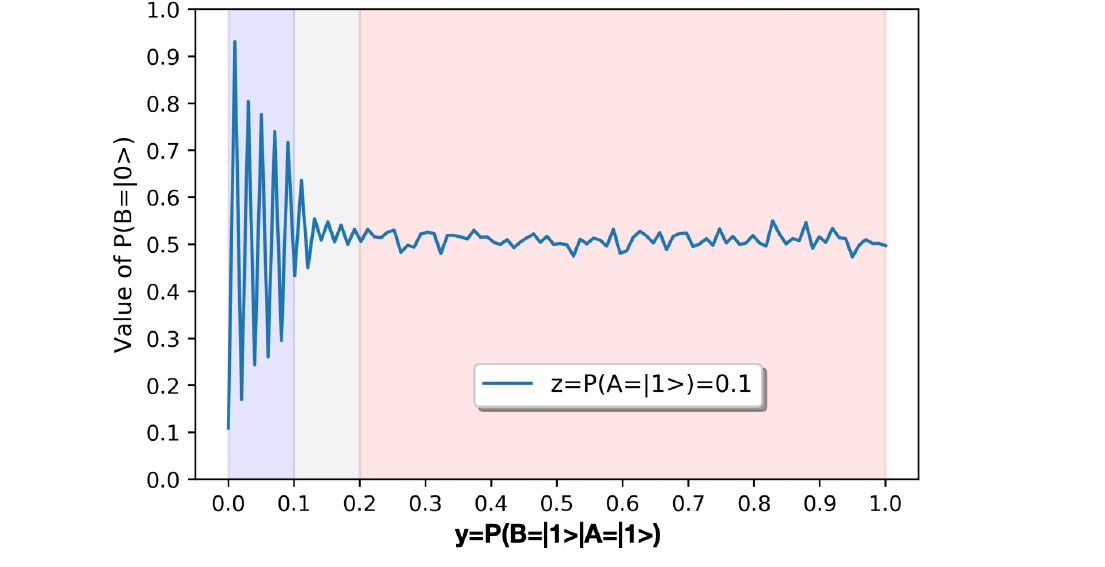
) as a function of 0 | (cid:105) ) [ 0,0.3 ] . 1 1 A = | (cid:105) | | (cid:105) ∈